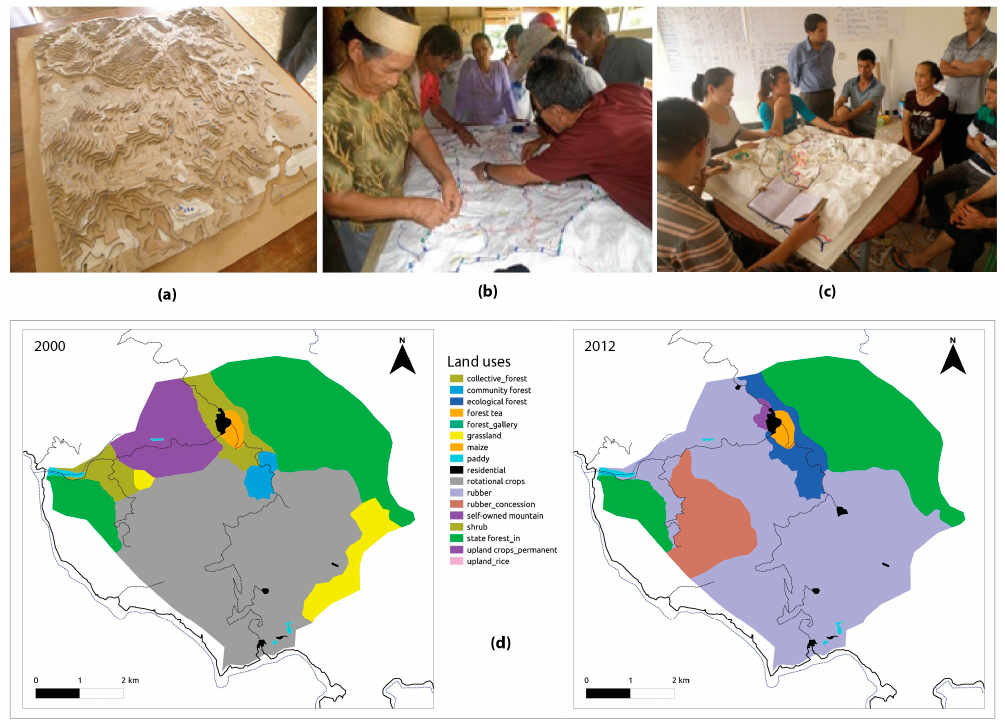
Figure 3. Participatory mapping using 3D models of the villages and land ‐ use maps 2000 and 2012 in Manlin Village, China : ( a ) Construction of a 3D model; ( b ) delineation of land uses by villagers; ( c